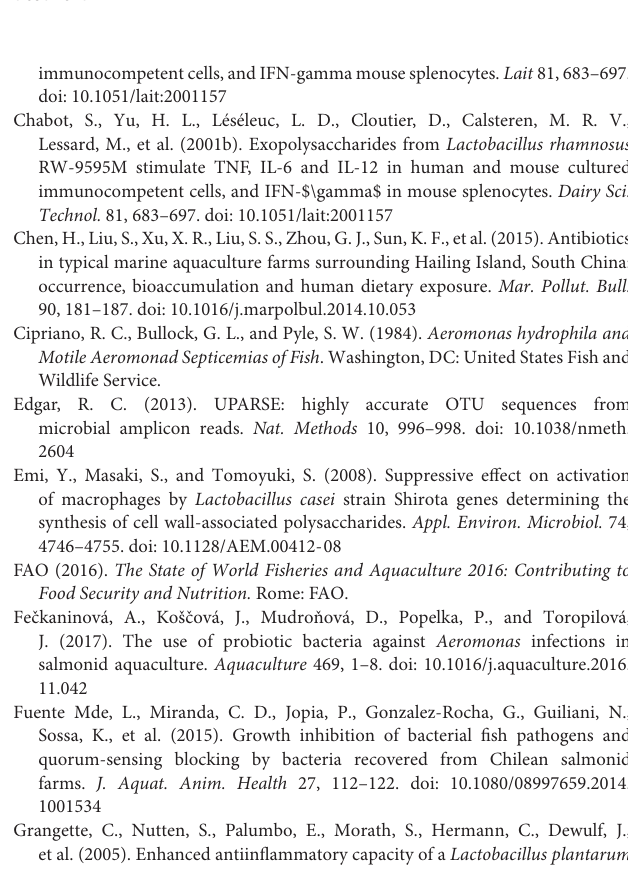
FIGURE S1 | The anti-infective effect of potential protiotics against Aeromonas veronii in zebrafish larvae. FIGURE S2 | Gut microbiota of zebrafish from control or Lactobacillus casei BL23 treated fish at class (A) , order (B) , and family (C) level. FIGURE S3 | The mRNA levels of TLR3a (A) , TLR3b (B) , TLR4a (C) , TLR5a (D) , TLR5b (E) , MyD88 (F) , and NF- κ B (G) in ZFL cells from control